Question: What visual encoding does this figure use to show its data?
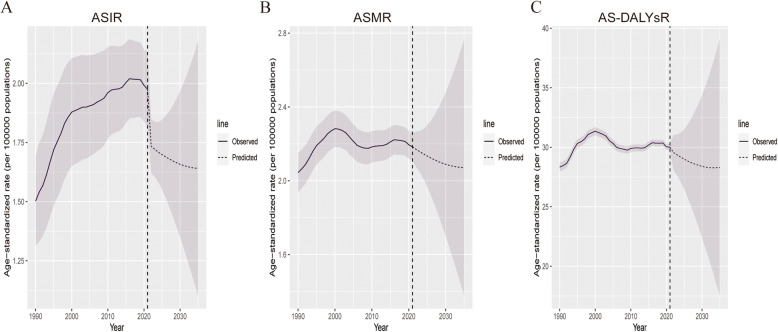
Answer: line